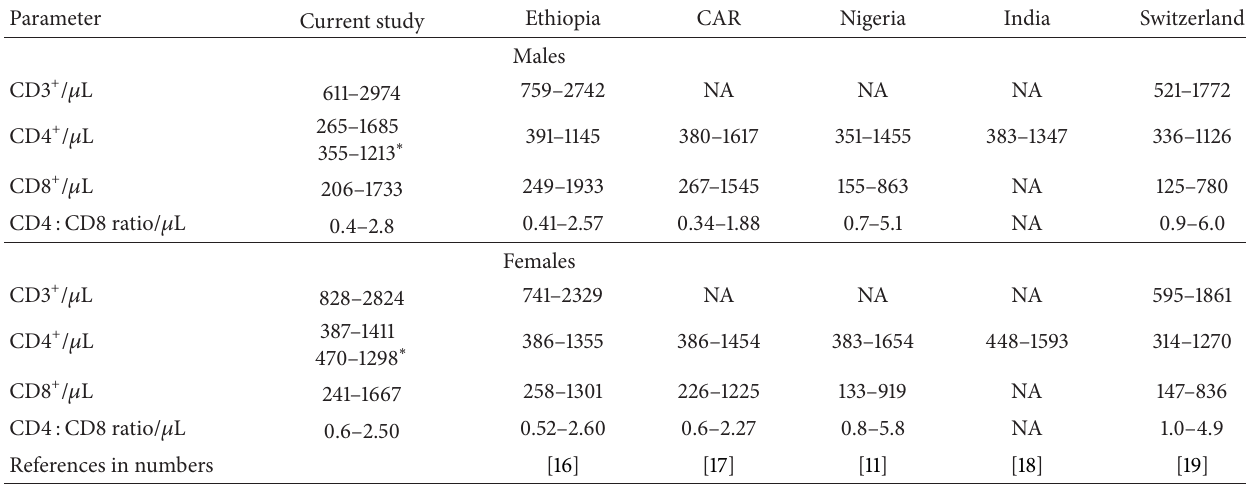
Table 4: Gender based 95% reference interval of HIV negative adults visited VCT, University of Gondar Hospital, Ethiopia, 2013, as compared with other countries.